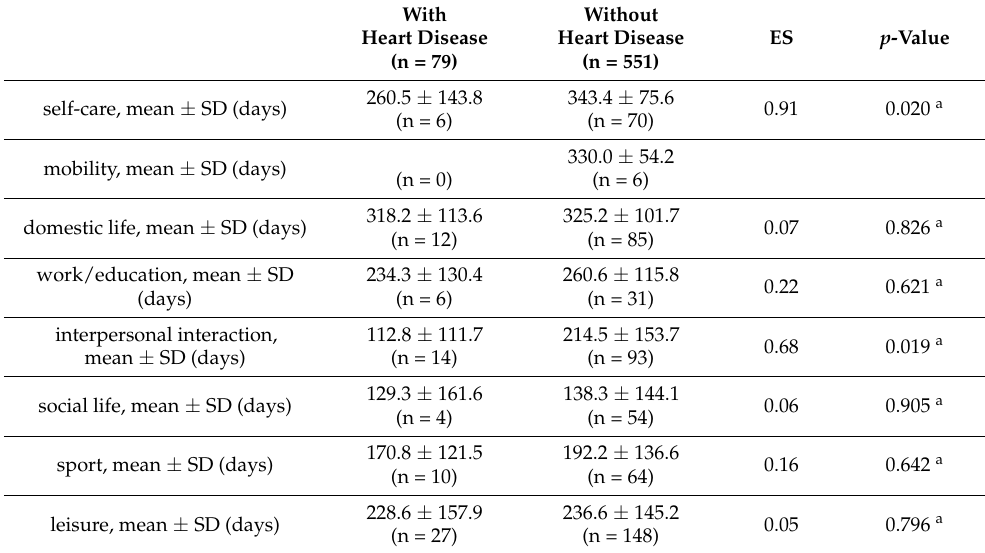
Table 5. Frequency of Meaningful Activities by Category.